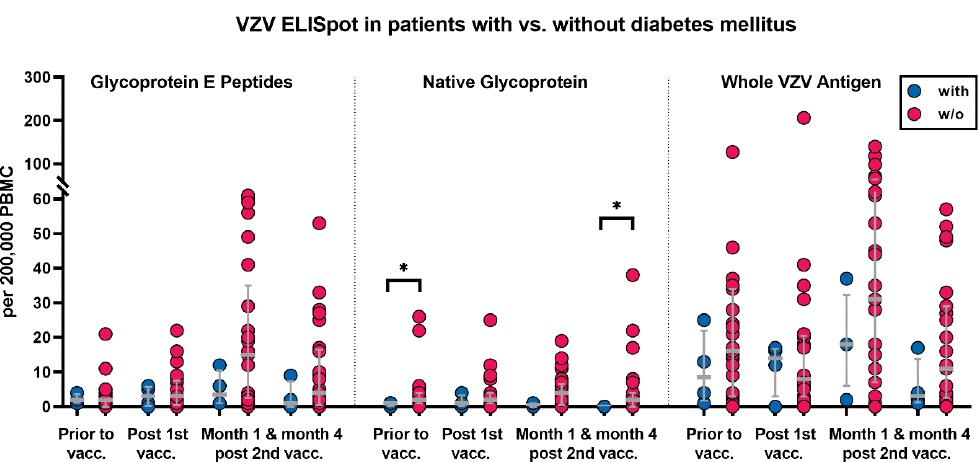
Figure 4. Varicella–zoster-virus-specific ELISpot responses in kidney transplant recipients with and without diabetes mellitus prior to and after the first and second vaccination with Shingrix™. Blue dots indicate four patients with diabetes mellitus (with) and red dots indicate 25 patients without (w/o). VZV-specific spots were determined as stimulated minus non-stimulated (background) values (spot increment). Gray horizontal lines represent median values and the interquartile range. Data were compared by using a Mann – Whitney test (* p < 0.05).